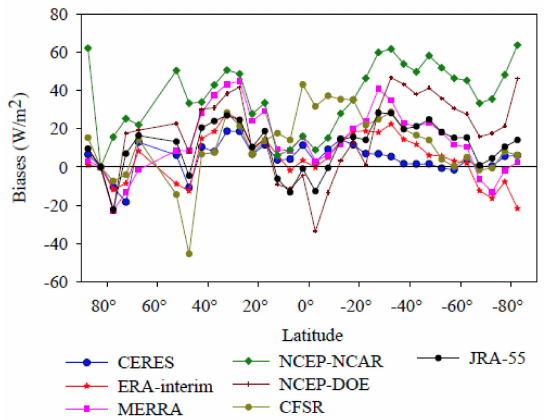
Figure 2. Monthly R s biases at the 674 sites as a function of latitude, for six different reanalysis and one satellite-derived (CERES-EBAF) R s products. Biases are averaged over sites within 5 ˝ latitudinal bands from 2001 to 2009. Units are W/m 2